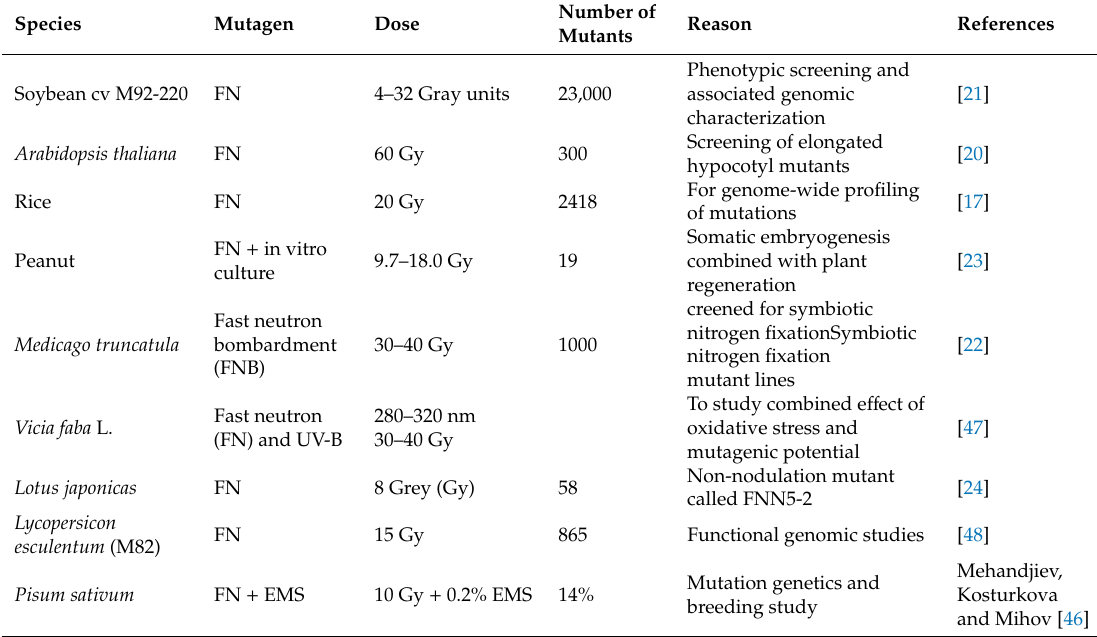
Table 3. Details of significant studies performed with fast neutron (FN) radiations and FN combined with other